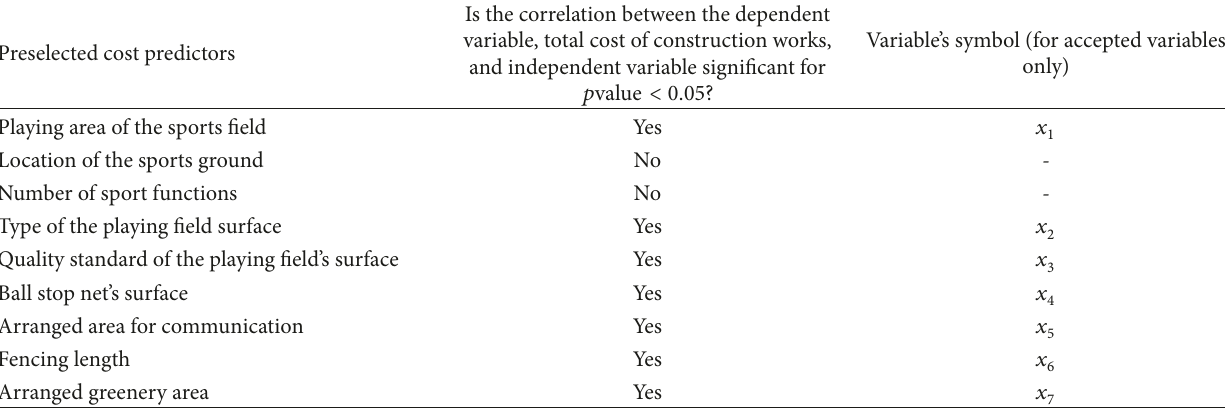
Table 3: Significance of correlations between the variables (source: own